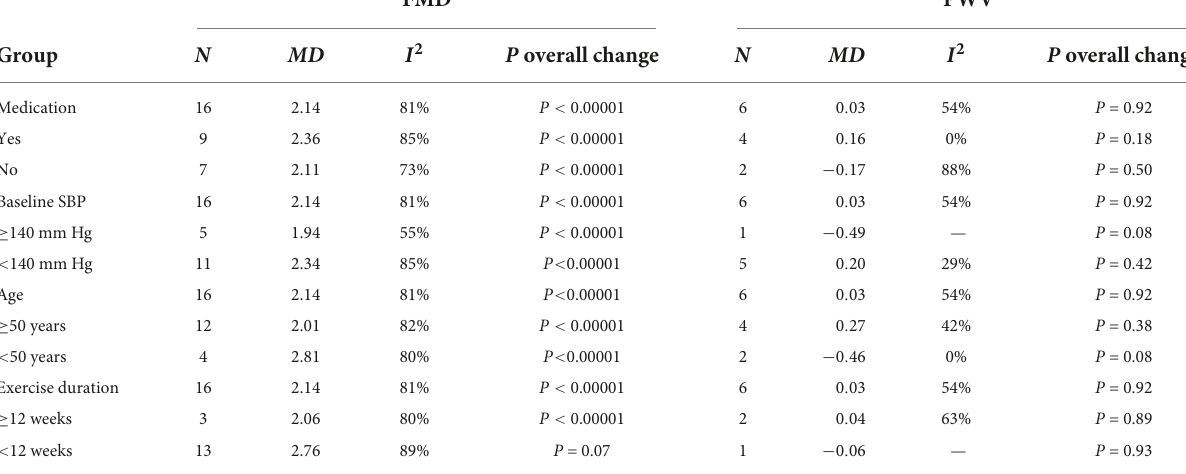
TABLE 3 Subgroup analyses for FMD and PWV in studies included in the